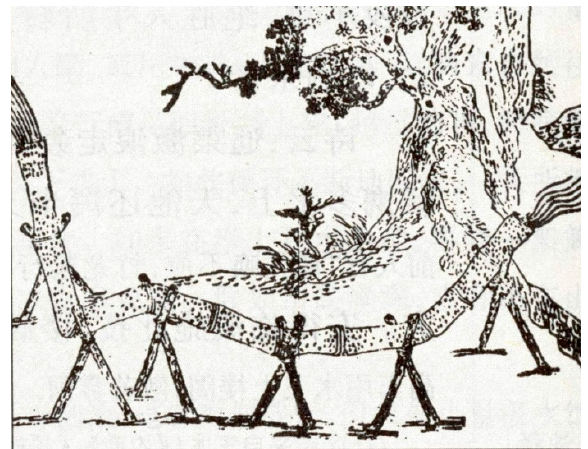
Figure 13. Bamboo pipes